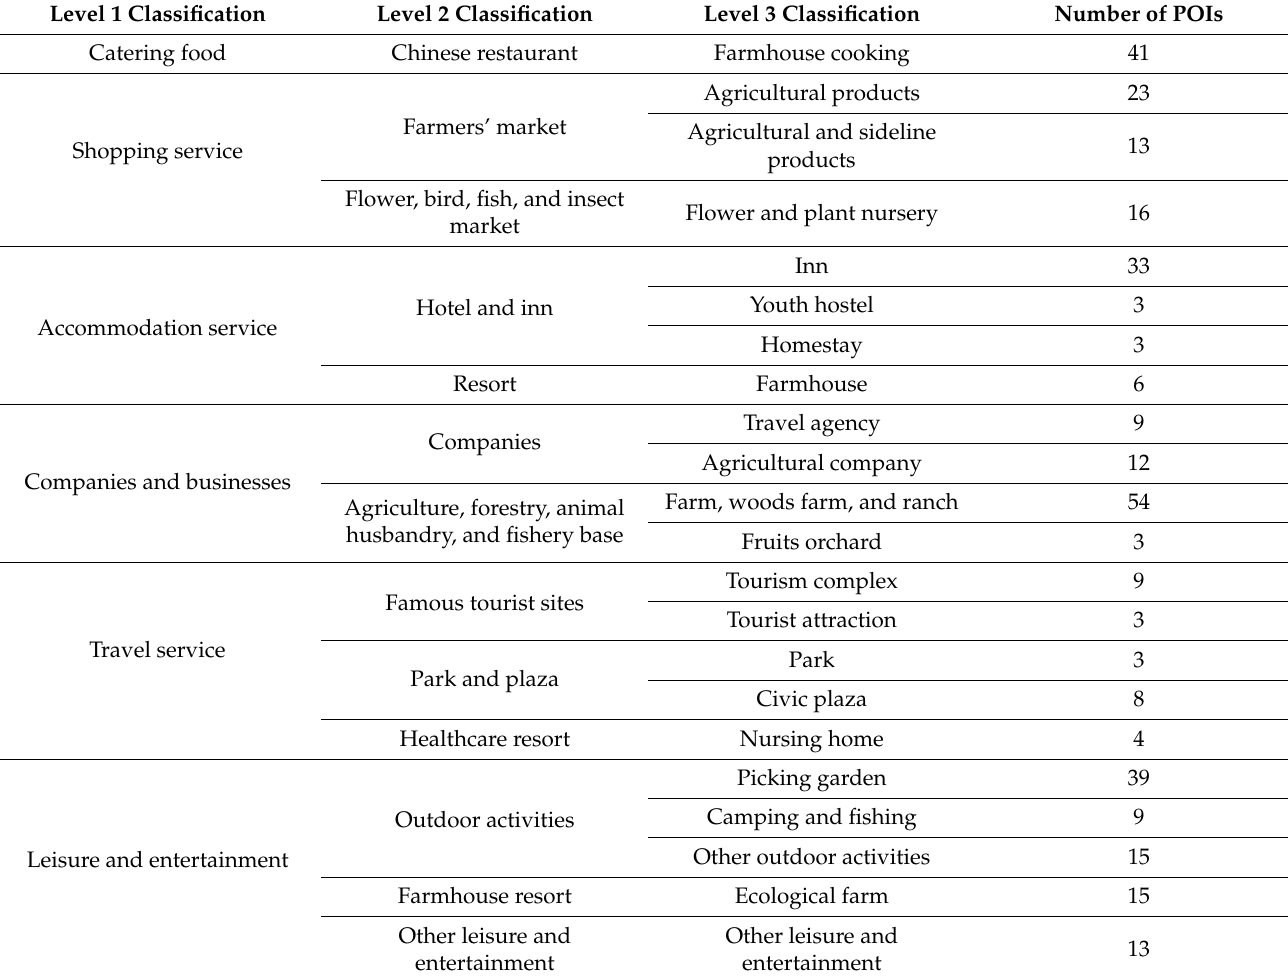
Table 1. Classification of cultivated land leisure service POI in Yuanyang